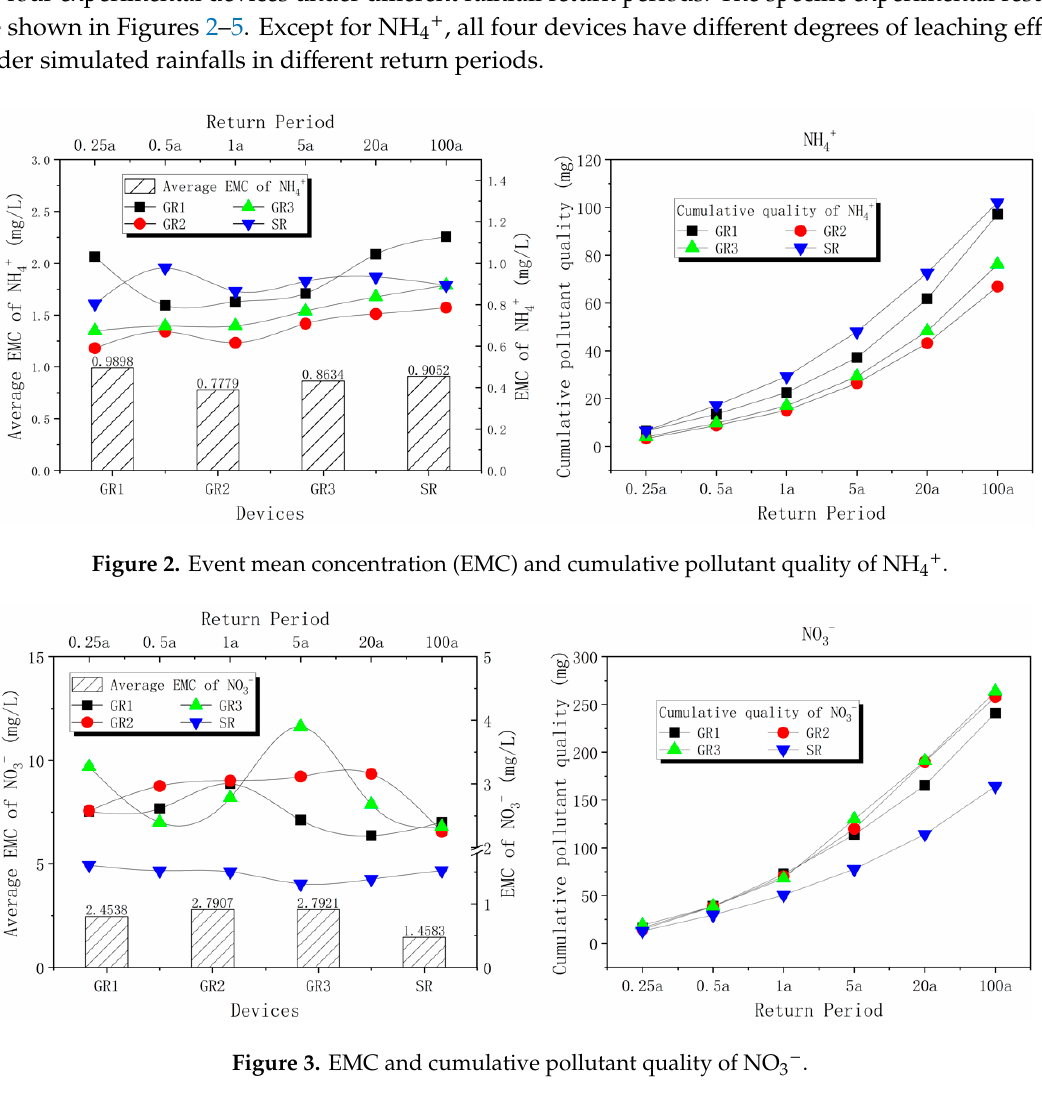
Figure 3. EMC and cumulative pollutant quality of NO 3 − .